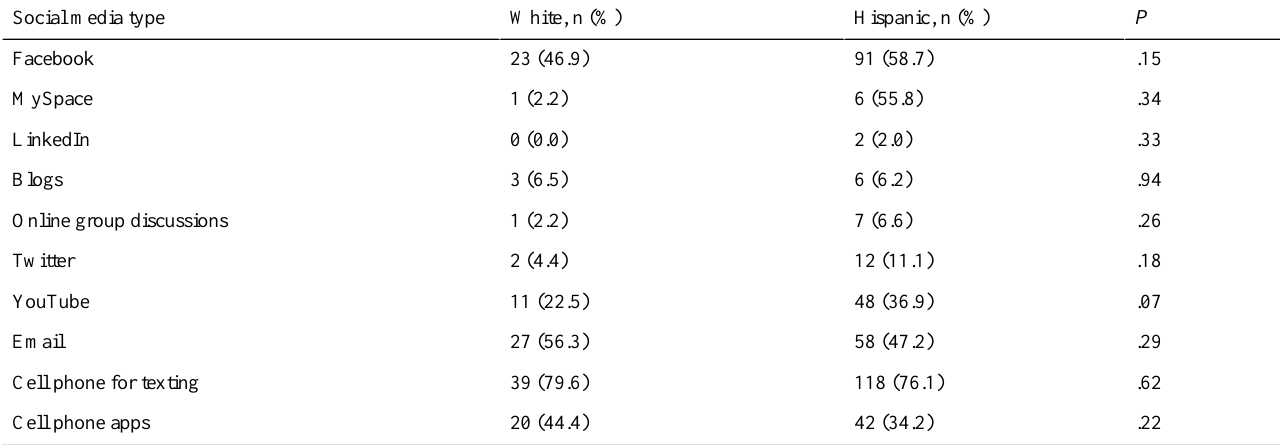
Table 2. Daily social media use among community health center patients (N=214).